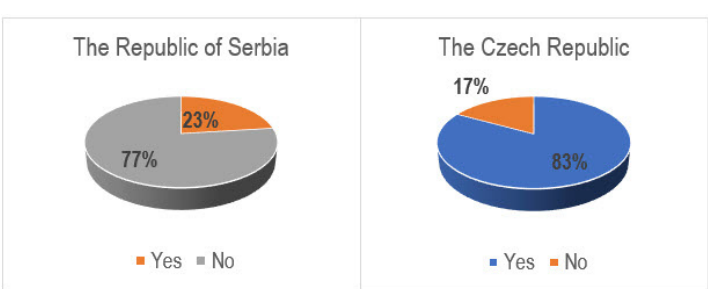
Figure 2. Do you think that the educational system in your country is at a satisfactory